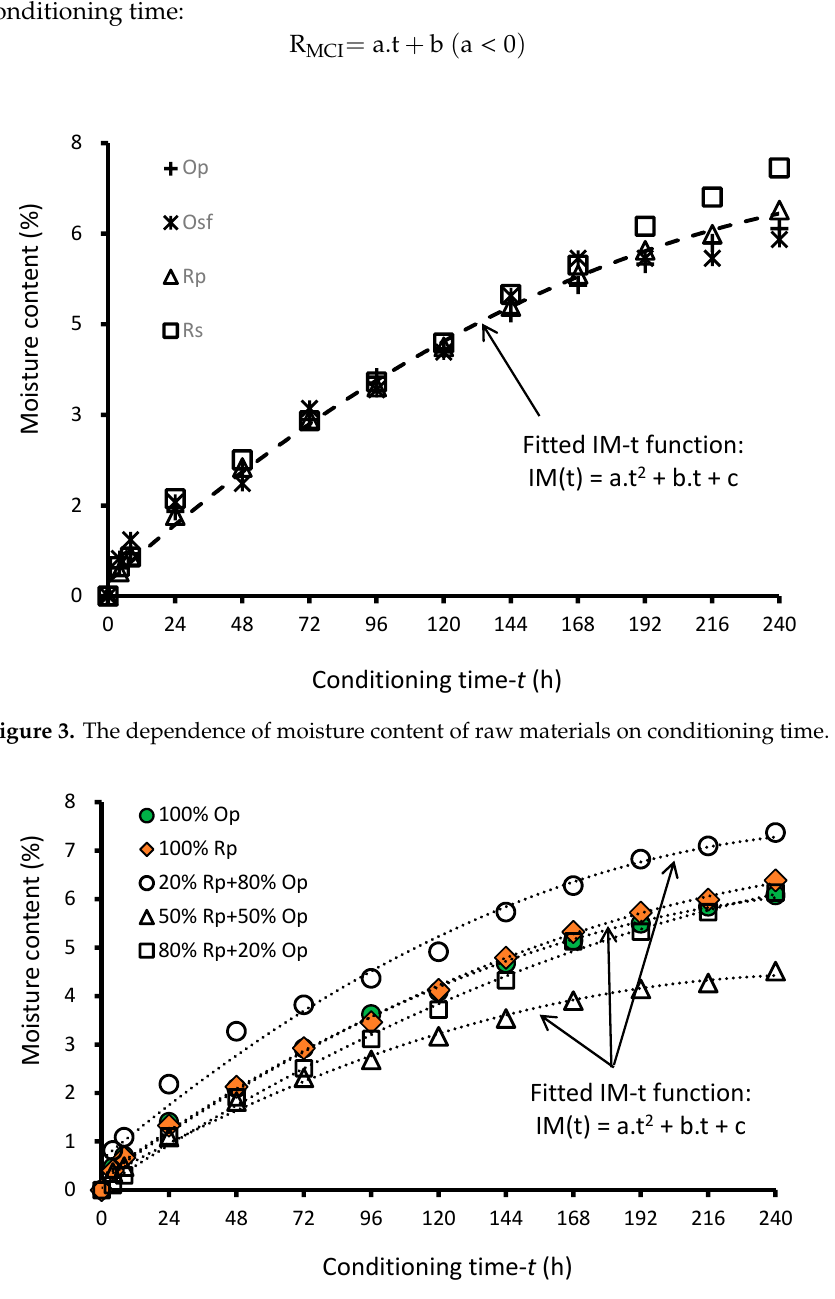
Figure 4. Exemplified relationship between increased moisture content and conditioning time for OSB-straw mixed biofuel sticks (Op plus Rp).